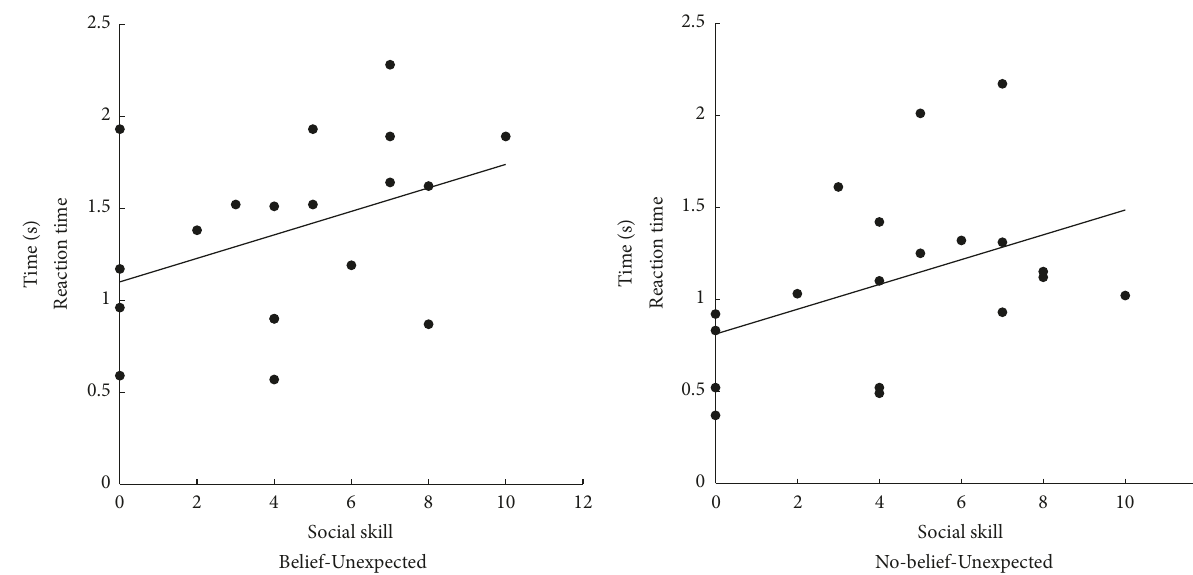
Figure 3: Correlation analysis of social skill and reaction time in the Belief Unexpected condition and in the No-belief Unexpected